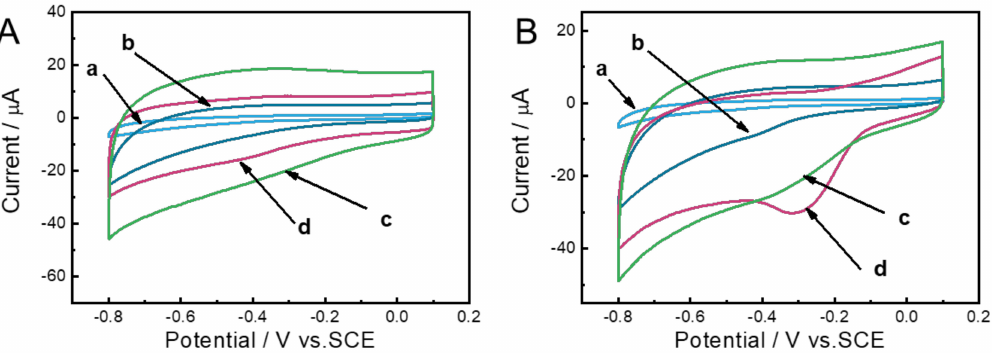
Figure 3. Raman spectra of Fe-BC-900.